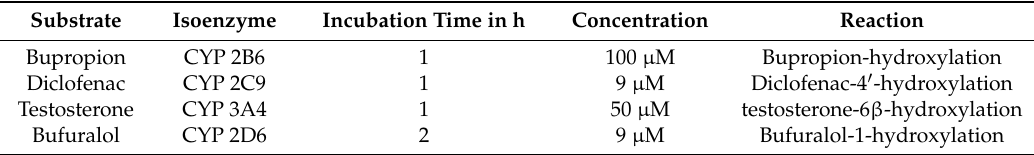
Table 1. Substrates, concentrations, conditions, and measured reactions of the CYP activity